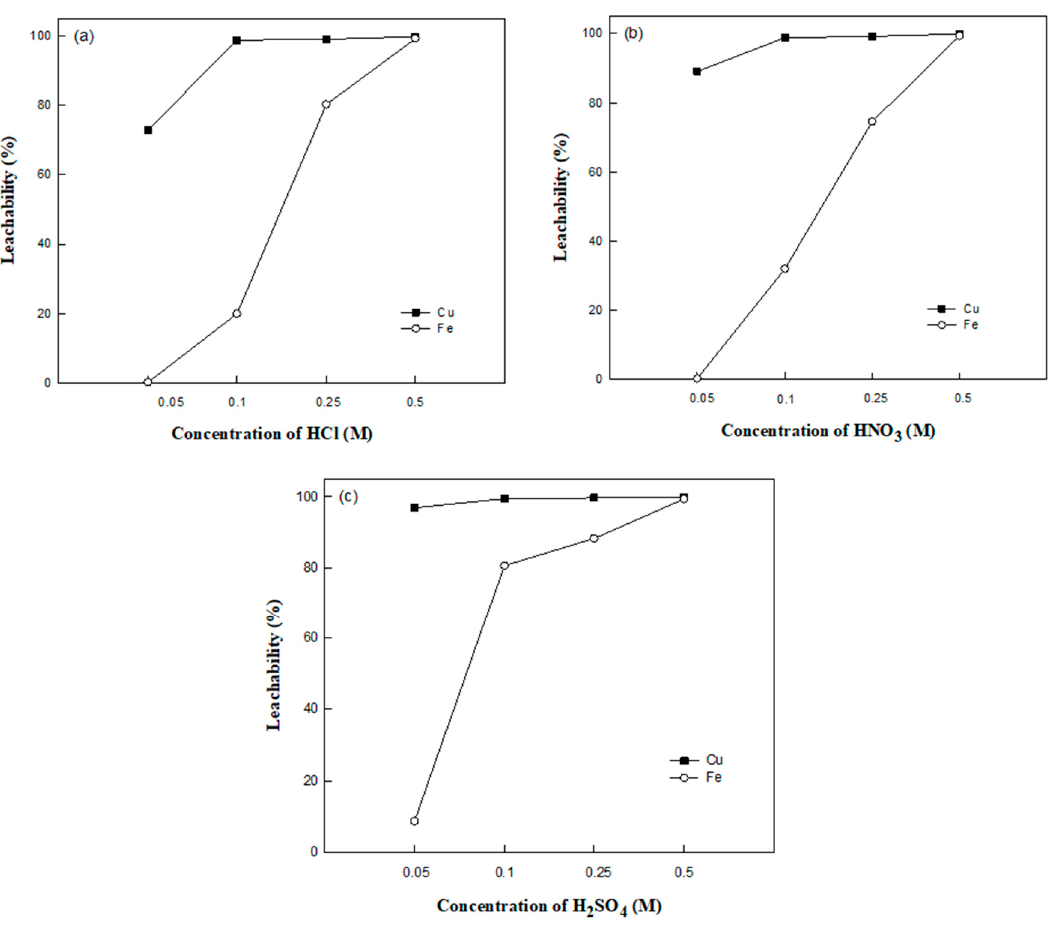
Figure 4. Cu and Fe leachability with variation of ( a ) HCl concentration, ( b ) HNO 3 concentration, ( c ) H 2 SO 4 concentration.